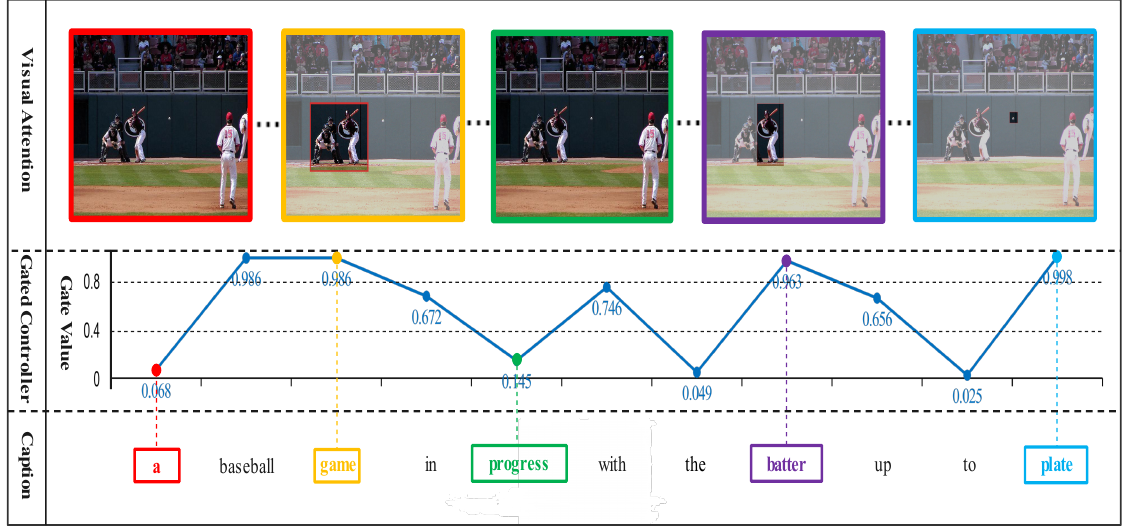
Figure 6. Visualization of attention regions in the caption generation process for PoS-Transformer and gate value of each generated word for controlling the flow of visual features and language signals attended to. By virtue of the PoS information and gated controller, PoS-Transformer is able to adaptively adjust the effect of visual features and language signals on the predicted visual or nonvisual